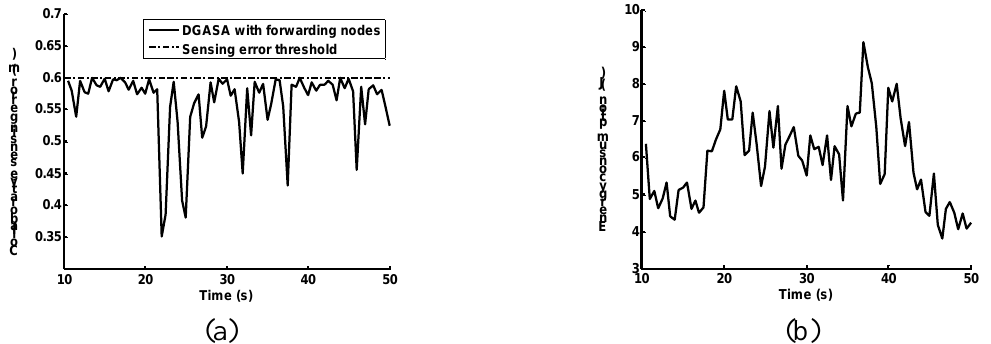
Figure 10. DGASA optimization results with forwarding node percentage set as 10%: (a) Collaborative sensing error; (b) Energy consumption.